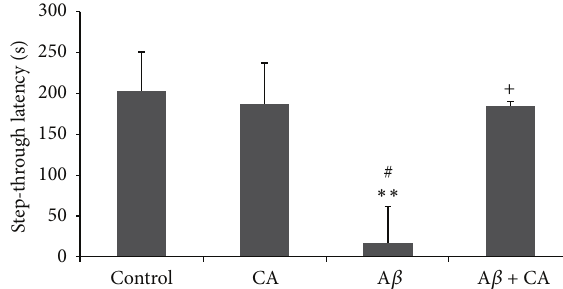
Figure 1: Step-through latency in the experimental groups (control, CA: carnosic acid, A 𝛽 : Amyloid beta, and A 𝛽 + CA: carnosic acid + A 𝛽 ) (mean ± SEM): ∗∗ 𝑃 < 0.01 compared to the control; # 𝑃 < 0.05 compared to the CA group; + 𝑃 < 0.05 compared to the A 𝛽 group.